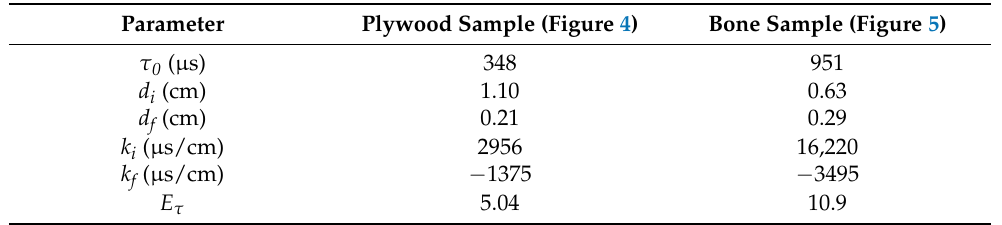
Table 1. Values of τ 0 , d i , d f , k i , k f and E τ (the minimum value of e τ ) corresponding to the linear by part regression analysis (cid:101) τ (see Equation (2)) obtained with the minimization procedure for the samples shown in Figures 4 and 5.